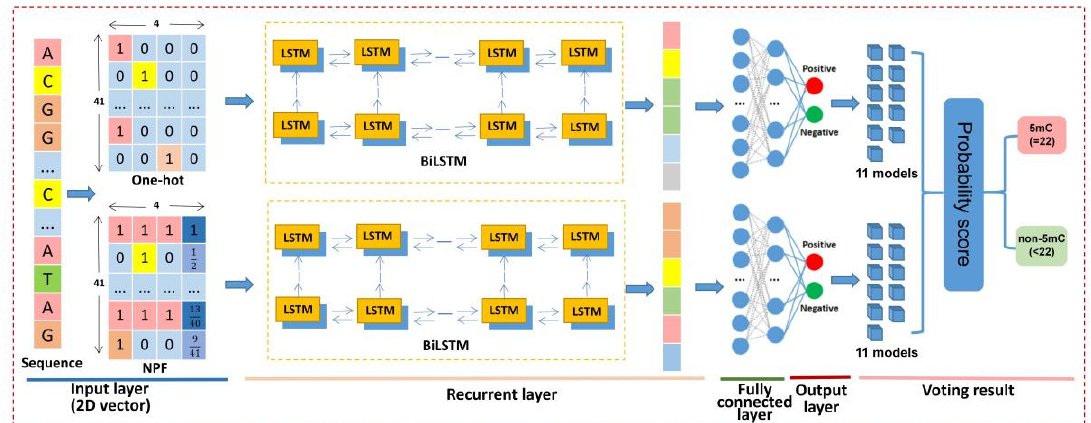
Figure 5. The structure of the BiLSTM-5mC framework.